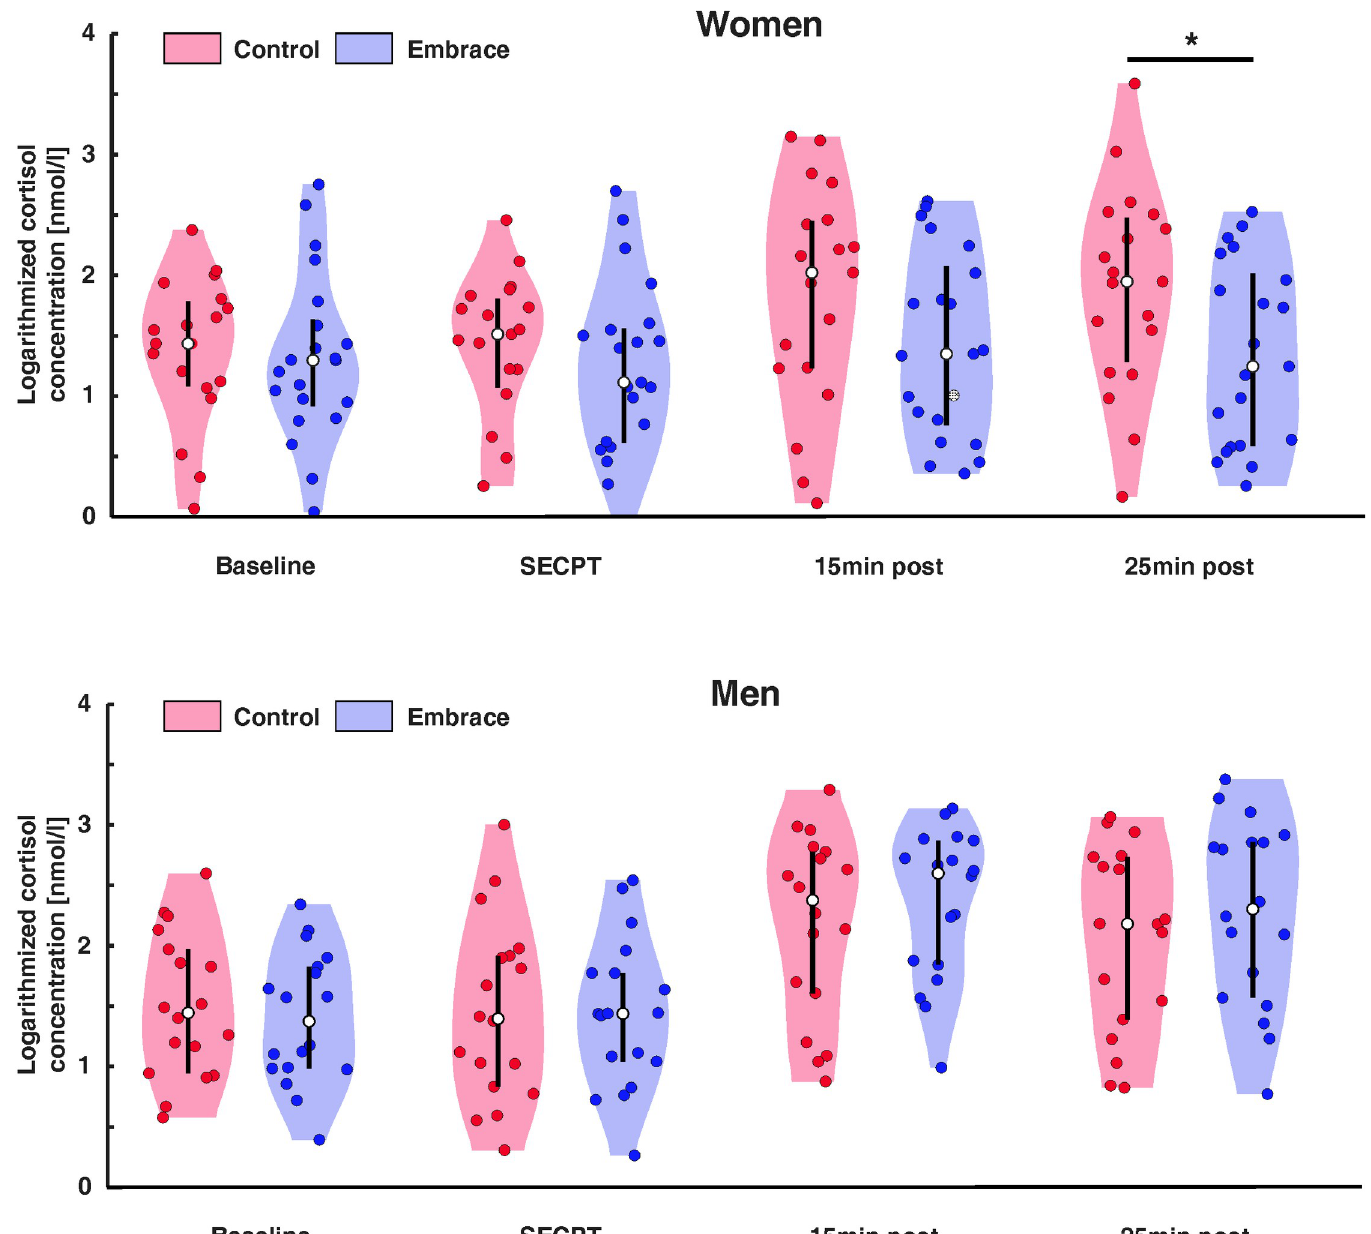
Fig 2. Cortisol concentration for women (top) and men (bottom) during baseline, the SECPT and 15 minutes as well as 25 minutes post SECPT for the embrace and control condition. White dots represent the median value for each group. Error bars represent the upper and lower quartiles. Group differences between the conditions are marked. � = p <